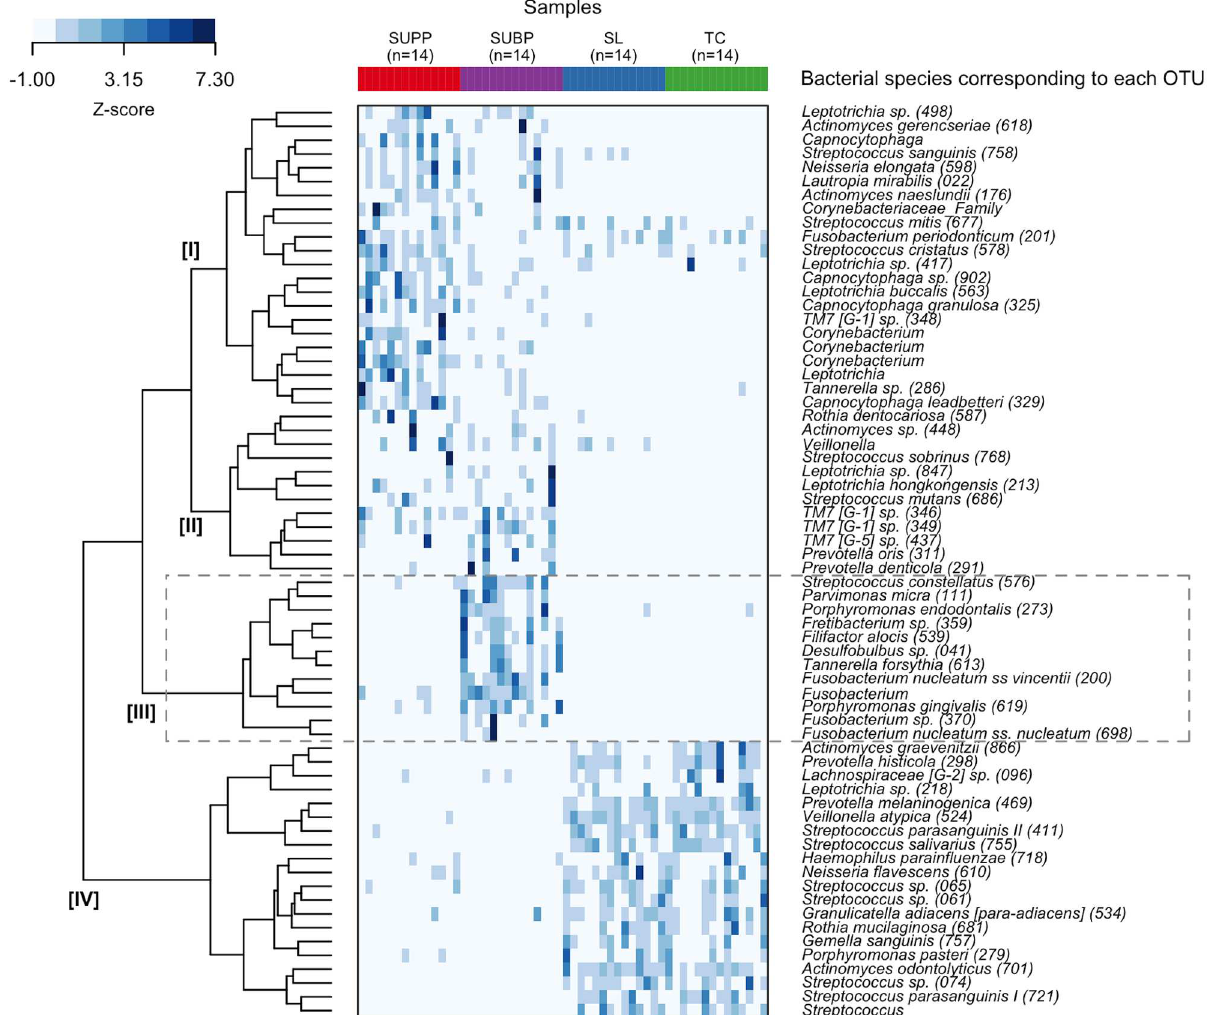
Fig 1. Relative abundance distribution of the 66 OTUs whose mean relative abundances in the pre-therapy samples from any of 4 niches exceeded 1%. The relative abundances of each OTU were normalized to a mean of 0 with standarddeviationof 1 (z-score normalization) and are represented by the blue gradientin each grid (light = low abundance;dark = high abundance). The OTUs were ordered basedon the result of a hierarchicalcluster analysisusing the Bray-Curtis distance, which is depicted as a dendrogram on the left side of the diagram. The 12 OTUs belongingto cluster III were characteristically more predominant in SUBP as comparedto microbiotafrom the other three niches. It is displayedin the box with a brokenline. Oral taxon IDs were given in parentheses followingbacterialnames.